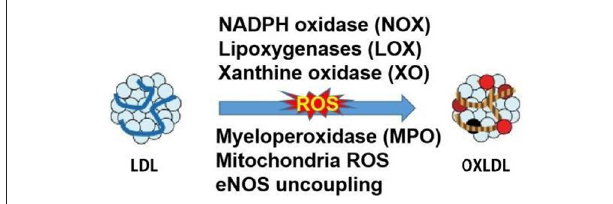
FIGURE 2 | Enzymes that cause LDL